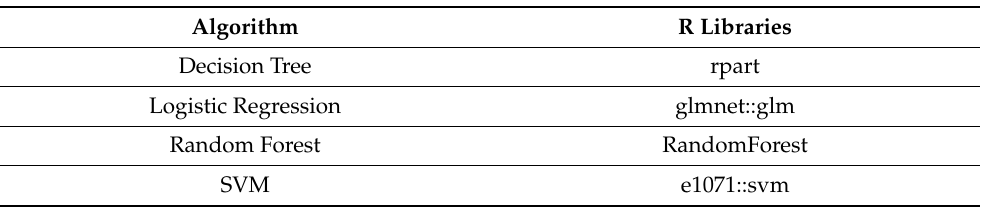
Table 4. Machine learning algorithms and the corresponding R